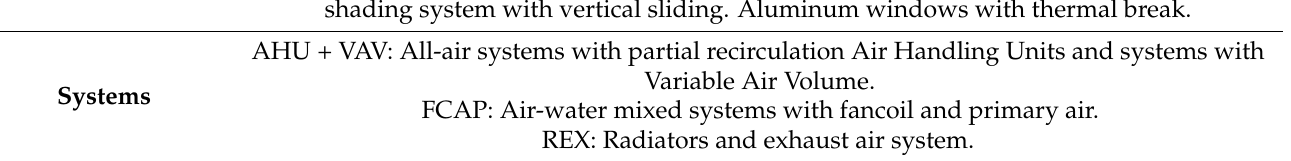
Table 6. Main features of the office Building 8 of Politecnico di Milano, Lecco Campus. Uses layout Offices: Administration, university offices and meeting rooms. Envelope